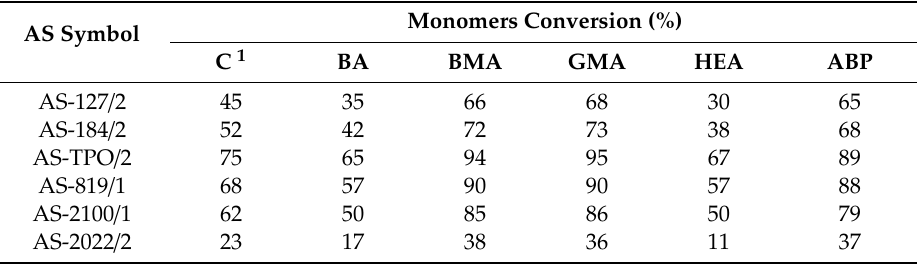
Table 4. Monomers’ conversion calculated by proton nuclear magnetic resonance ( 1 H NMR)